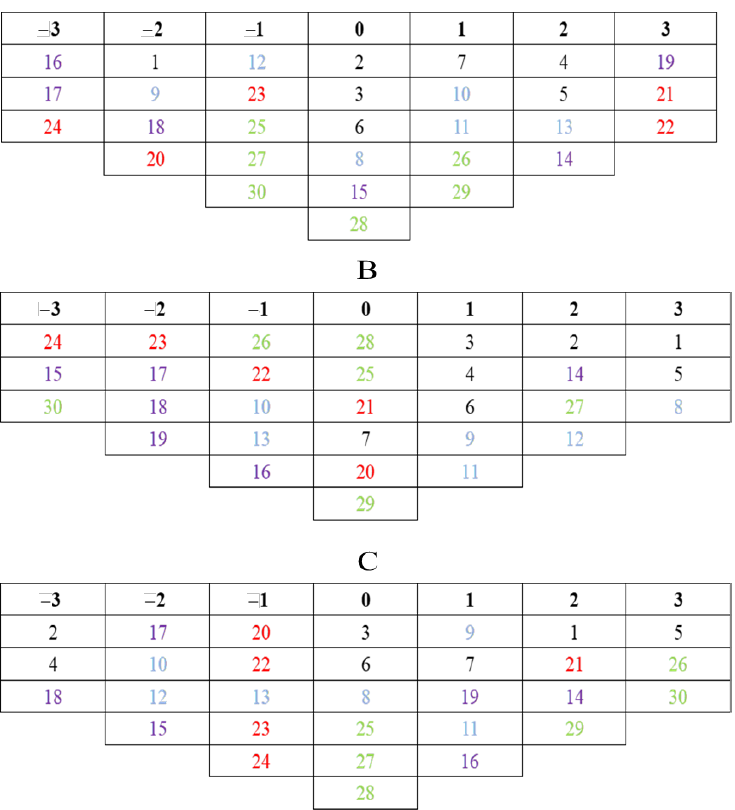
Figure 4. Types of tourists. And ( A ) represents preference for humanities-natural recreation; ( B ) represents preference for aesthetics-sense of place; ( C ) represents preference for environmental education. The color of black, blue, purple, red, and green represents aesthetics, sense of place, cultural heritage, natural heritage, and environmental education, respectively.